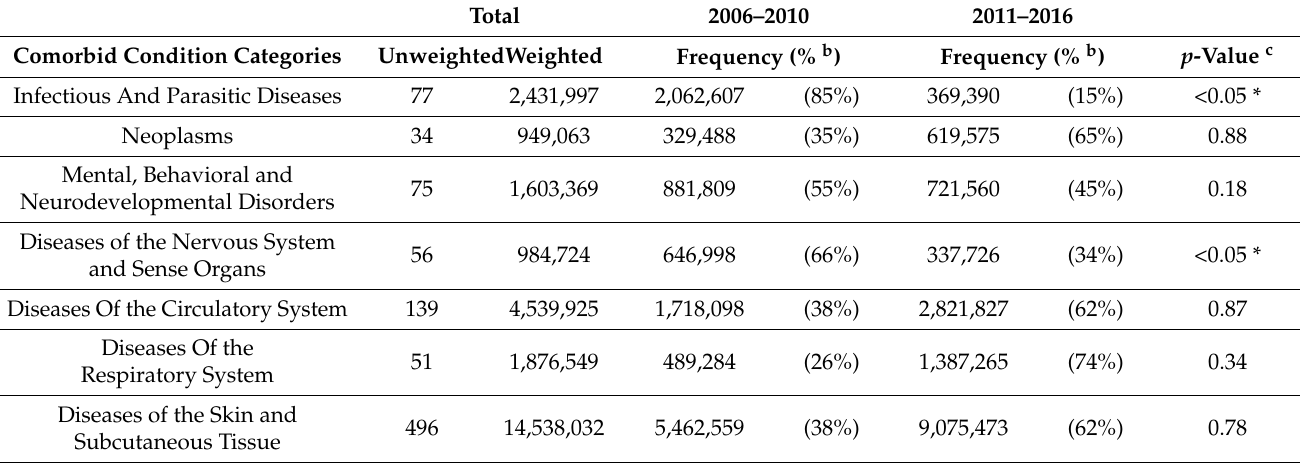
Table 3. Common comorbidities observed in lupus patient visits from 2006 to 2016 (identified by ICD-9 and ICD-10